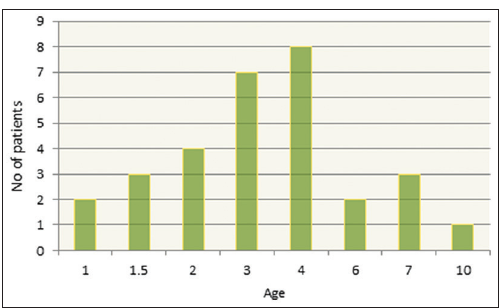
FIGURE 3. Age structure of the treated patients